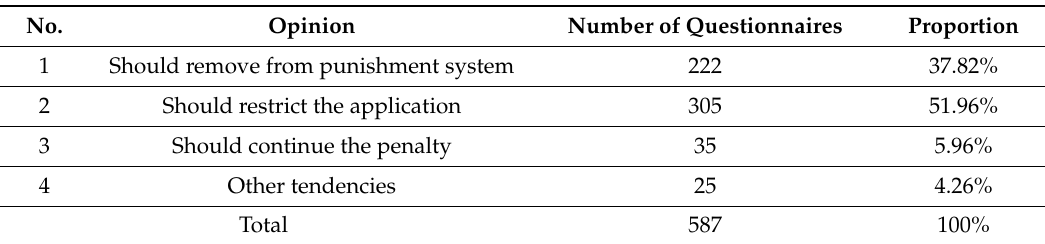
Table 5. Opinion on the death penalty of the first group. (The first group consisted of convicts who have been incarcerated in prison. In the survey, 587 questionnaires were distributed to convicts who received a termed imprisonment sentence in three di ff erent prisons in three separate provinces of Vietnam, including Thanh Hoa, Bac Giang, and Hanoi. Source: [94]).